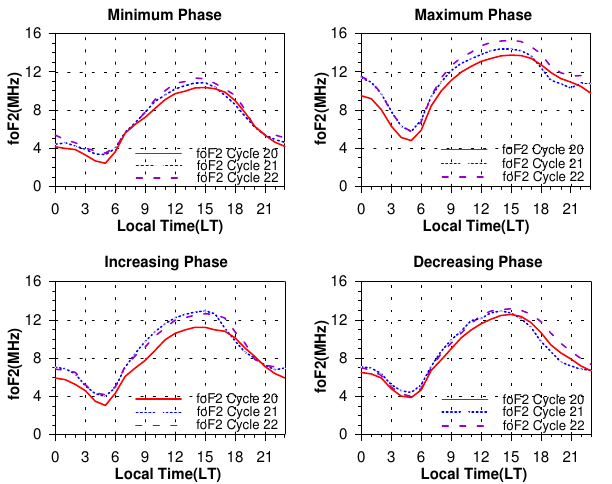
Fig. 10. Similar to Fig. 8 for h 0 F2.